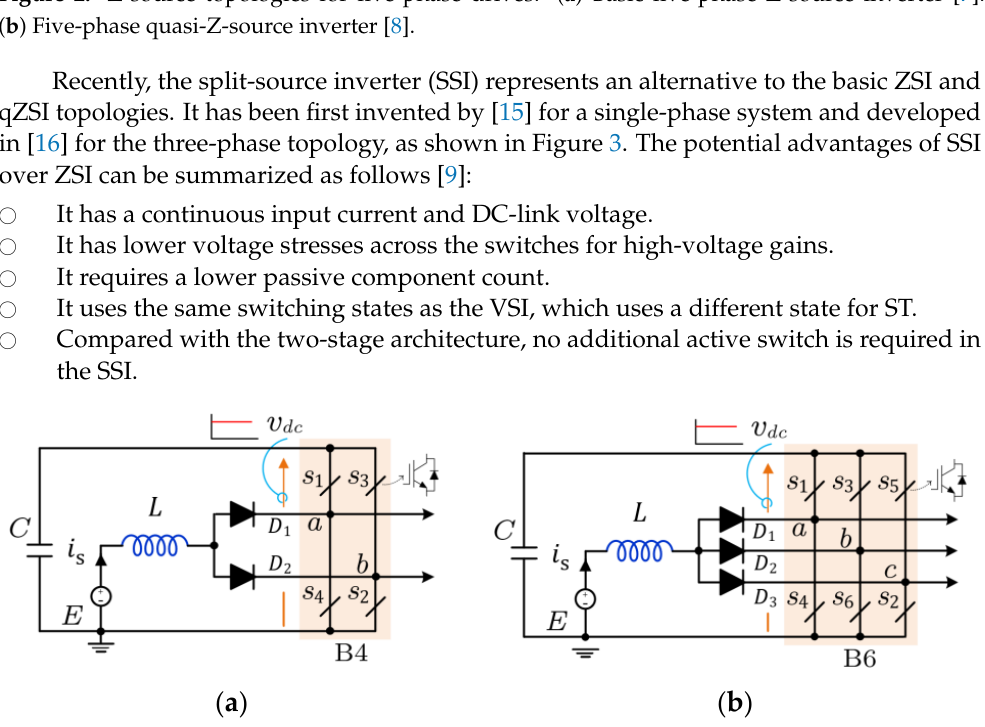
( b ) Figure 3. Basic SSI topology, ( a ) single-phase SSI [15], and ( b ) three-phase SSI [16]. Several topologies have been developed with the idea of the basic SSI to achieve higher boosting capabilities [17 – 19], multilevel technologies [20 – 22], and multiport output